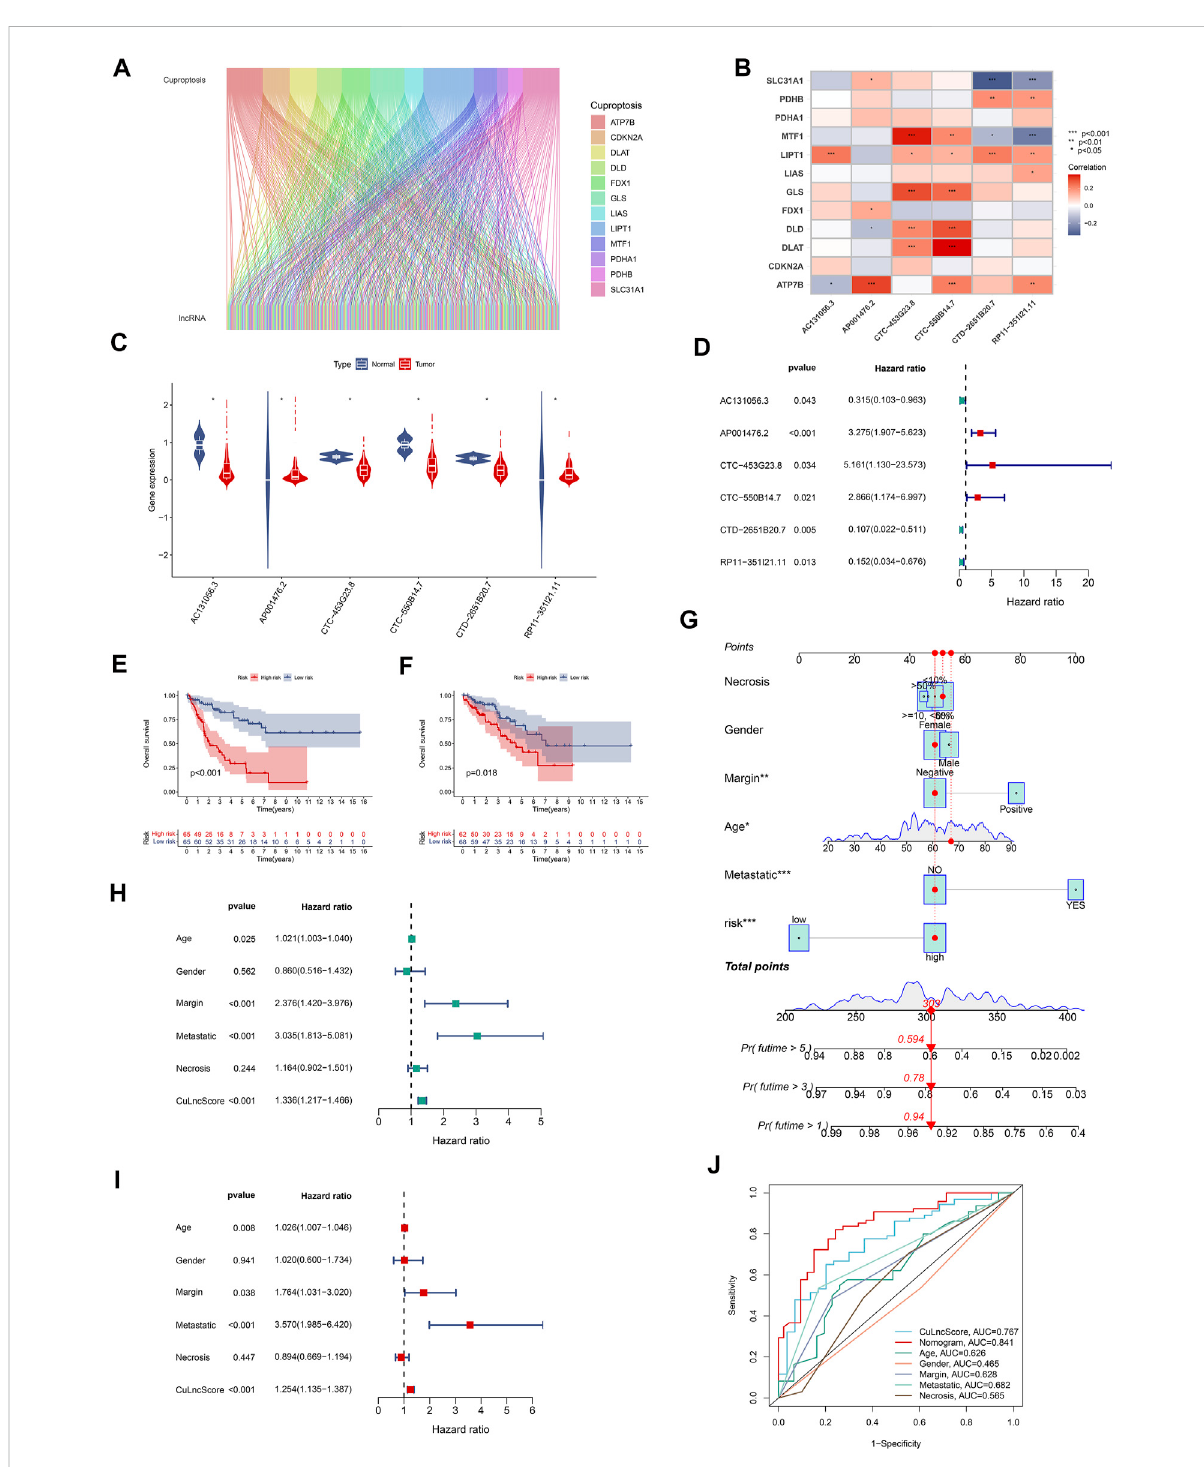
FIGURE 1 ClinicalrelevanceofCuLncScore. (A) ThelncRNAsthatareco-expressedwithcuproptosis-relatedgenesintheTCGA-SARCcohortarelabeled cuproptosis lncRNAs. (B) The co-expressioncorrelationof sixcuproptosislncRNAs for constructingtheCuLncScore model with cuproptosis genes. (C) Variable expression of cuproptosis lncRNAs in TCGA-SARC. (D) Cox regression analysis of TCGA-SARC with cuproptosis lncRNAs. Kaplan-Meier Curves for differential survival inhigh and low-risk groups in thetrain (E) and test (F) cohort. (G) A nomogramfor predicting the1, 3, and 5 years survivalratesofpatients.Univariate (H) andmultivariate (I) Coxregressionscon fi rmCuLncScoreasanindependentprognosticfactor. (J) ROCcurves for different risk factors. * p < .05, ** p < 0.01, *** p <